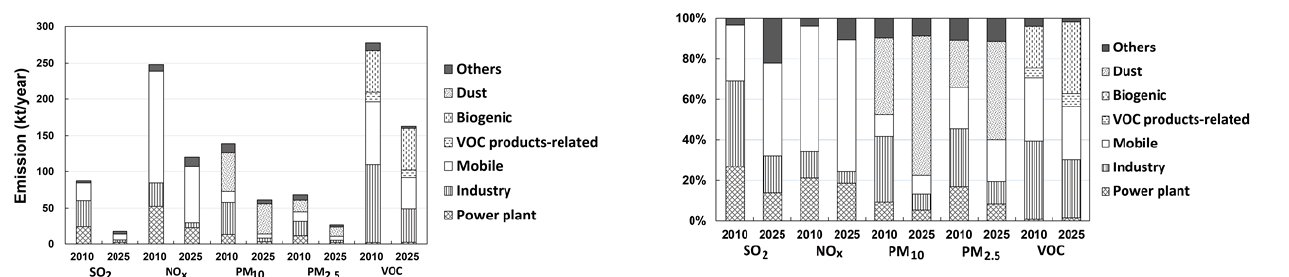
Fig. 9. Comparison of sector contribution in Guangzhou between 2010 and 2025.